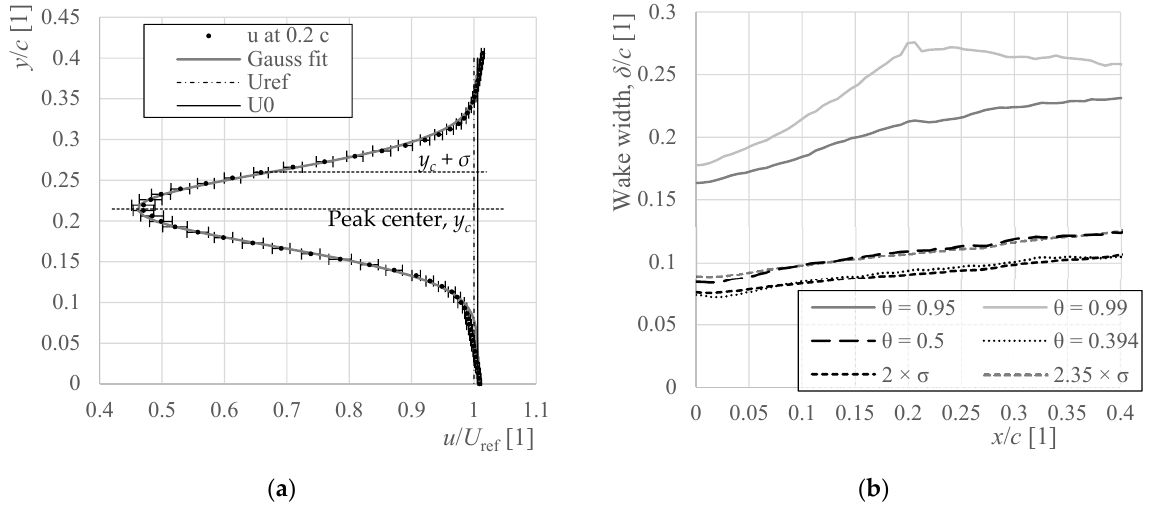
Figure 4. Panel ( a ) shows data at one of velocity profiles (Figure 2b) with corresponding Gaussian fit. There is shown the constant value of U ref , which is velocity measured in empty wind tunnel, and U 0 , which is the background of Gaussian fit. ( b ) The comparison of mentioned methods based on threshold (first four) or on the Gaussian fit (last two).